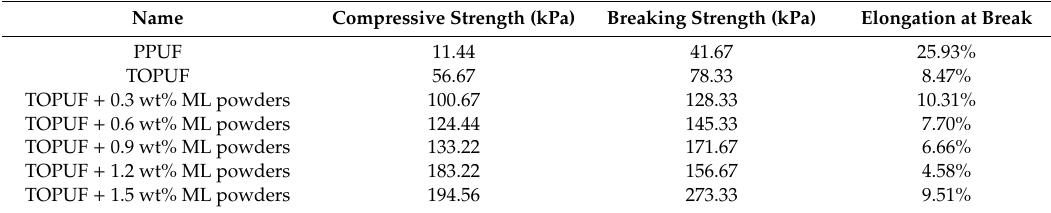
Table 6. Comparison of mechanical properties of several